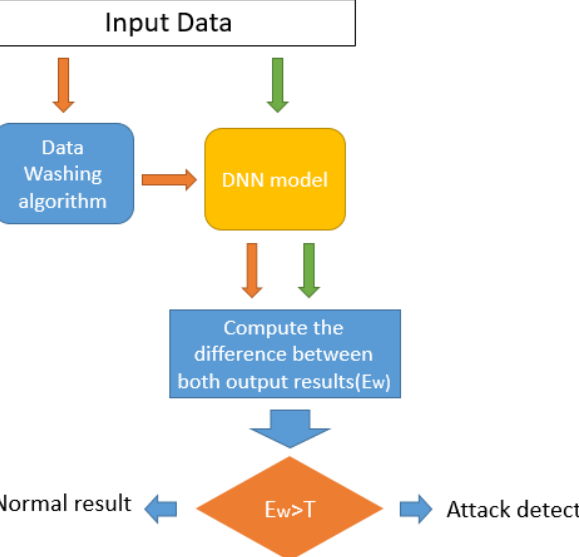
Figure 3. Flowchart showing detection of paralysis attacks in IDA algorithm.